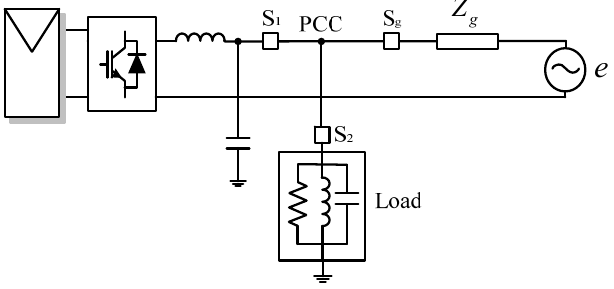
Figure 8. Photovoltaic system (PVS) power stage for islanding detection test.